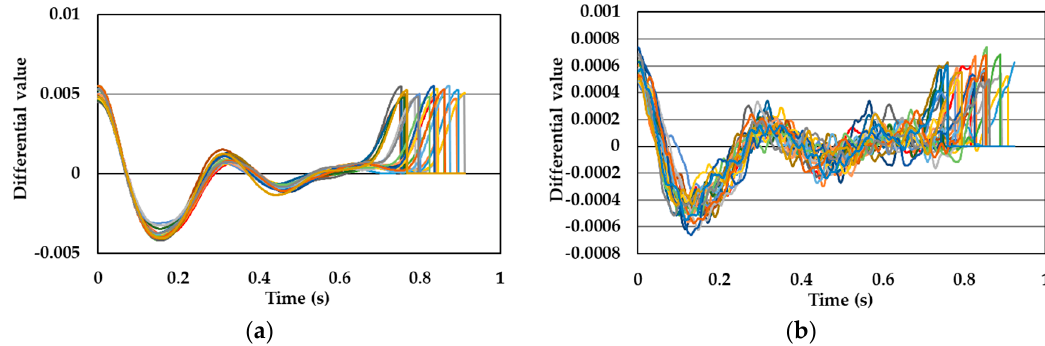
Figure 6. The single pulse wave signals of subject B: ( a ) POF-FBG sensor and ( b ) silica-FBG sensor.